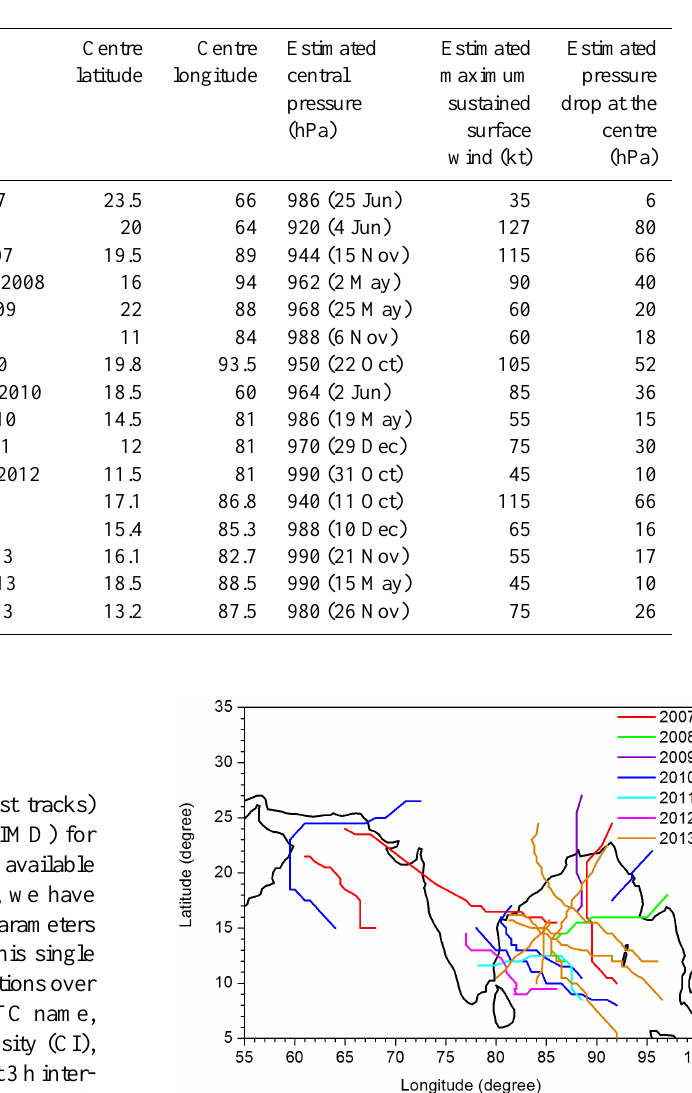
Table 1. Cyclone name, grade, cyclone intensity (CI) number, period, centre latitude, centre longitude, estimated central pressure, estimated maximum sustained surface wind, and estimated pressure drop at the centre of all the cyclones used in the present study provided by the IMD.